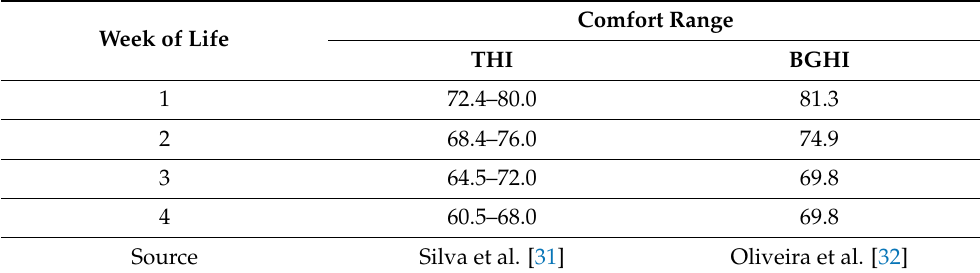
Source Silva et al. [31] Oliveira et al.